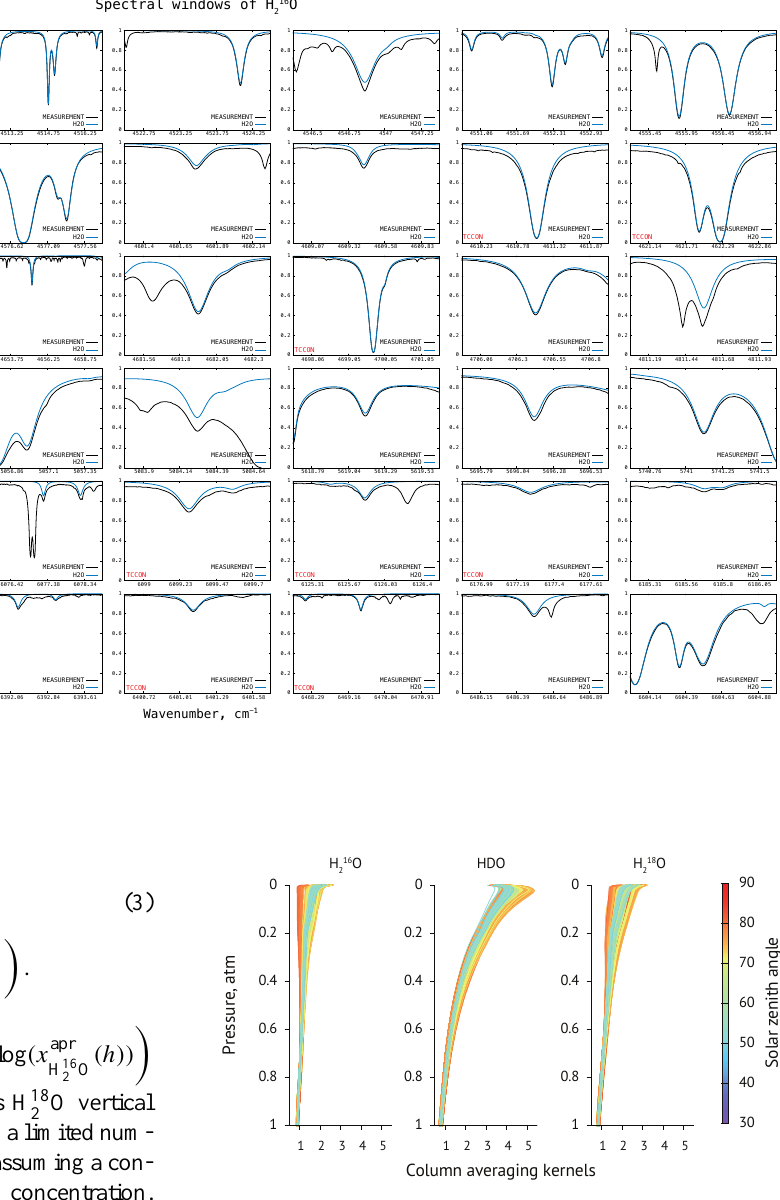
Figure 2. Column averaging kernels of H 16